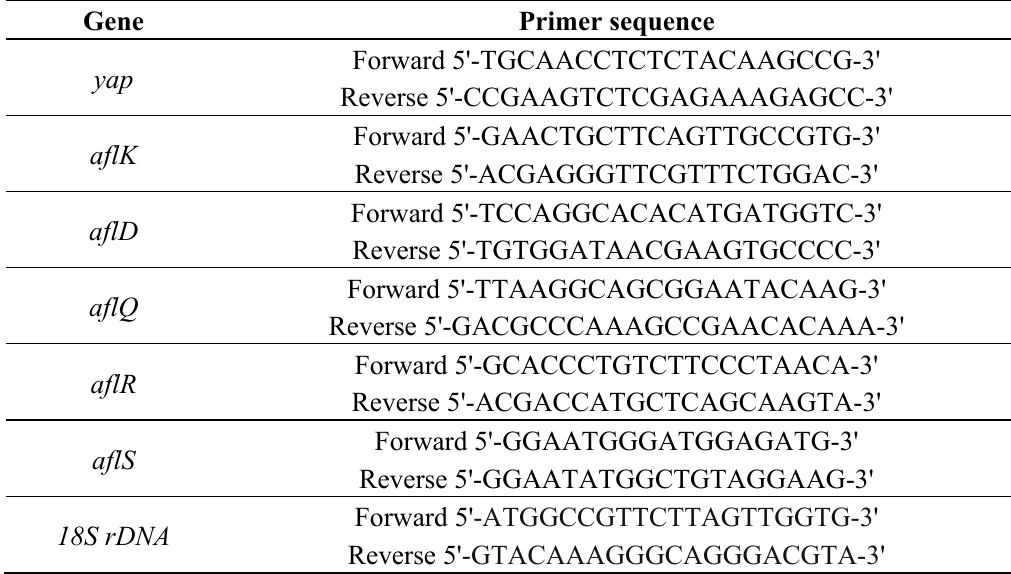
Table 2. Gene-specific primer pairs used for